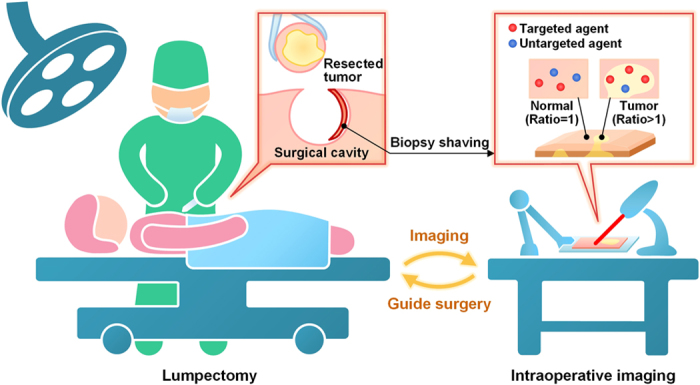
Schematic of an intraoperative imaging technique to rapidly identify residual tumors at the margins of freshly resected tissues for guiding breast-conserving surgeries.A ratiometric strategy (right inset) quantifies biomarker expression by comparing the signal from targeted NPs and nontargeted NPs. Y.W. drew the figure.